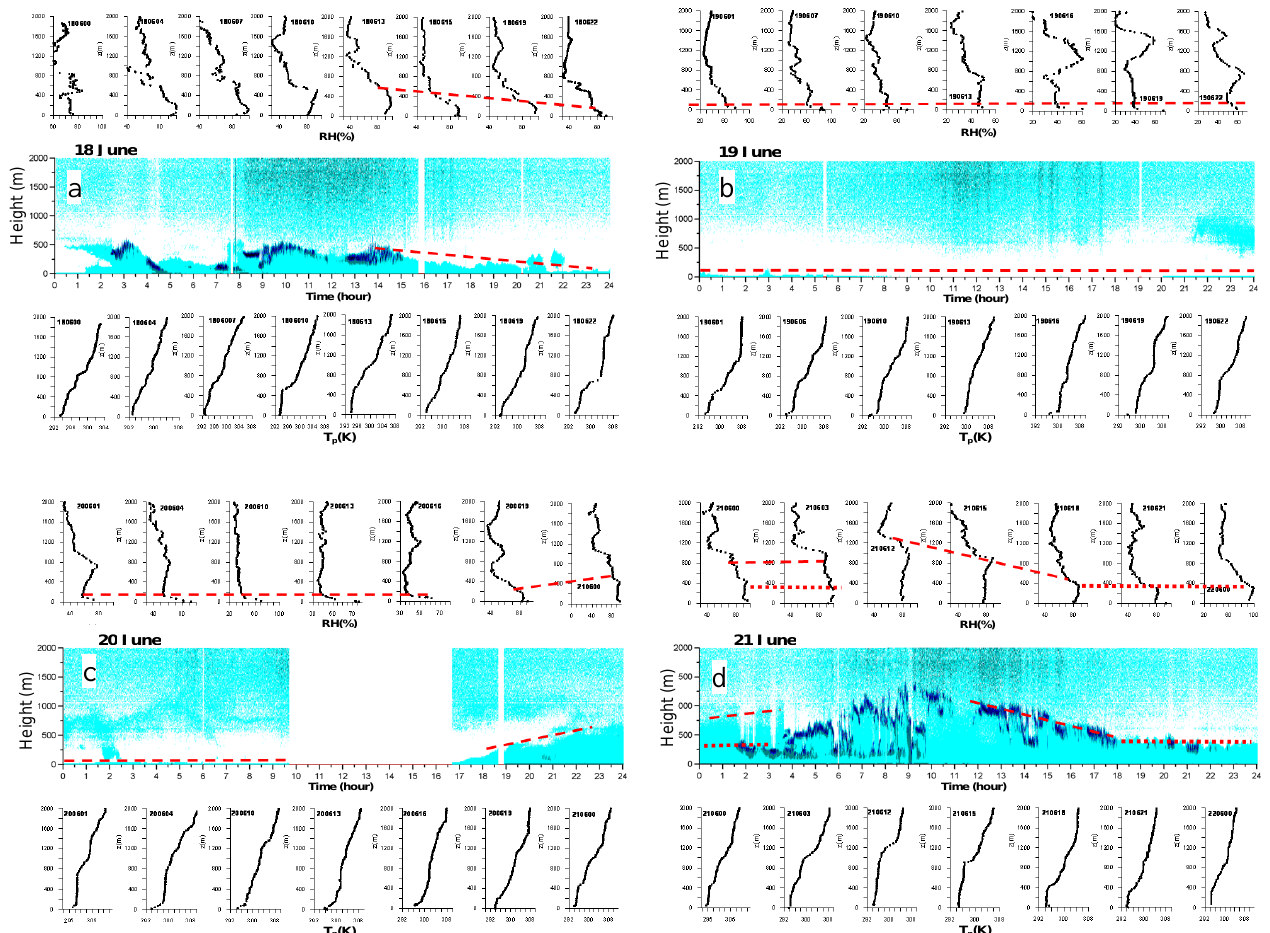
Fig. 5. Comparison of the development of the height of the MABL during 18 (a) , 19 (b) , 20 (c) and 21 (d) June 2007 from the ceilometer and single radiosonde profiles of T p and RH. In each figure, we show vertical profiles of relative humidity from radiosondes (top), backscatter from ceilometer (middle) and vertical profiles of T p from radiosondes (bottom). Red lines show the behaviour of z i from the two systems. Note that in panels (b) and (c) the humidity is trapped at the surface by the ground-based T p inversion.